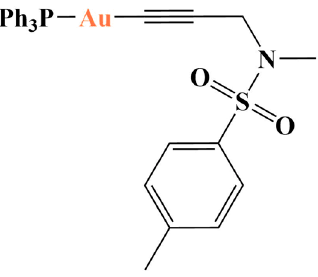
Figure 29. One of the complexes presented in [112]. Marmolandcoworkerssynthesizedandtestedalkynyl-gold(I)-substituted3-hydroxyflavones against a series of cancer cell lines [113]. Several alkyne-substituted ligands were coor- dinated with Au(I), together with either triphenylphosphane (PPh 3 ), or 1,3,5-triaza-7- phosphaadamantane (PTA) (Figure 30). Their antiproliferative activity, expressed as IC 50 against undifferentiated Caco-2/TC7 cells is within the micromolar range (IC 50 = 1.5–7.68 µ M, MTT assay).